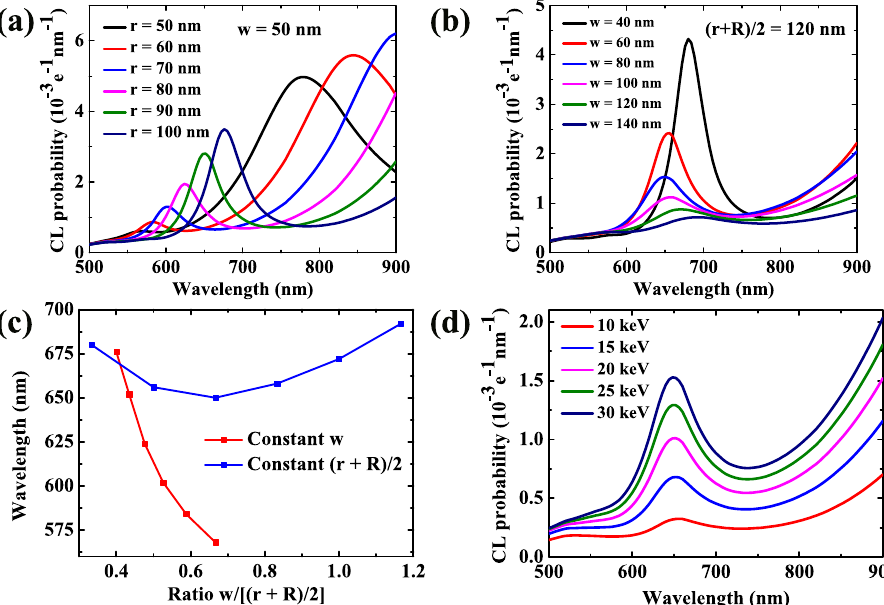
Figure 5. The influence of the ratio of the Au nanorings and the energy of electron beam on CL. The thickness of the Au nanoring h = 50 nm, the electron beam is incident at the position of ( r + R )/2 and the energy of electron beam is 30 keV for ( a – c ). ( a ) Calculated CL spectra for nanorings with a constant width of 50 nm and different inside radii r . ( b ) Calculated CL spectra for nanorings with a constant effective radius of ( r + R )/2 = 120 nm and different width w . ( c ) The relationship between the ratio parameter w /[( r + R )/2] and the resonant wavelength, which is extracted from ( a ) and ( b ). ( d ) The influence of the energy of electron beam for an r = 80 nm, w = 80 nm nanoring